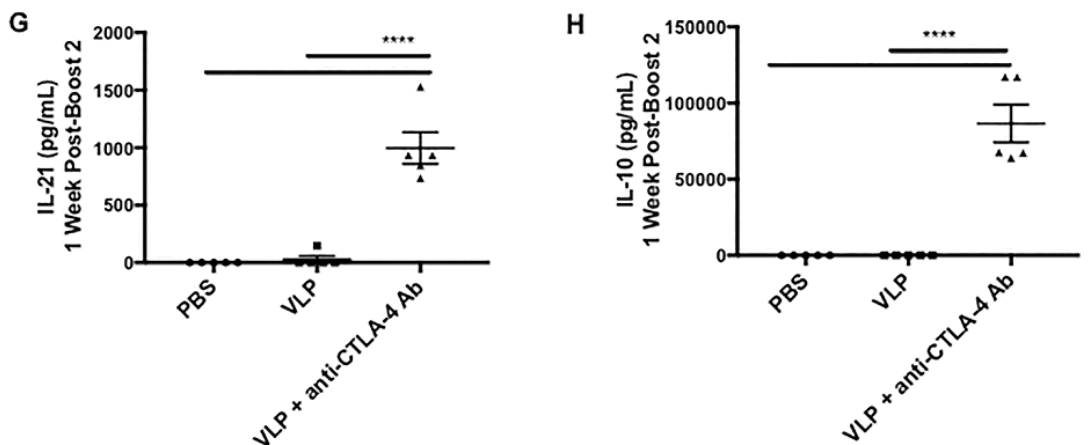
Figure 5. CTLA-4 blockade accelerates the induction of the plasma cell survival factor, A proliferation-inducing ligand (APRIL), and serum cytokines IL-10 and IL-21. Serum from Cohort 2 was diluted 1:100 in RIPA and Laemmli buffer and loaded for SDS-PAGE. Each 15-well gel was loaded with ladder and serum from 4 PBS mice, 5 VLP immunized mice, and 5 immunized VLP + anti-CTLA-4 Ab mice. ( A ) Western blot of APRIL at the indicated time points; ( B ) Densitometric analysis of APRIL expression levels. Serum samples from Cohorts 1 and 2 were analyzed for cytokines using Legendplex ™ bead-based immunoassay. Serum samples ( n = 30) were analyzed in duplicate and cytokine concentrations were calculated from a standard curve; ( C ) IL-21 post-prime serum levels; ( D ) IL-10 post-prime serum levels; ( E ) IL-21 post-boost 1 serum levels; ( F ) IL-10 post-boost 1 serum levels; ( G ) IL-21 post-boost 2 serum levels; ( H ) IL-10 post-boost 2 serum levels. Significance was determined by a one-way ANOVA and Tukey post-hoc analysis for multiple comparisons. A line on top of two groups indicates statistical differences between these two groups. **** p < 0.0001, *** p < 0.001, and * p < 0.05.